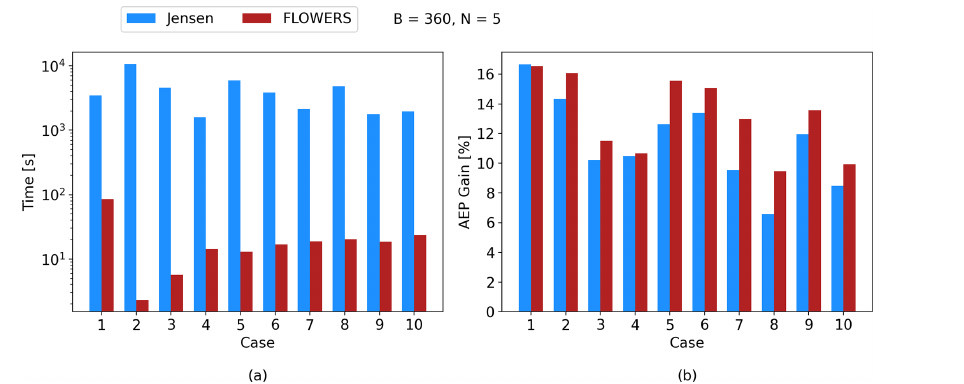
Figure 11. A multistart study, now for the Jensen model with B = 360 wind direction bins. The Jensen optimization now takes about 680 times longer than FLOWERS and achieves an AEP gain that is 1.7% lower.